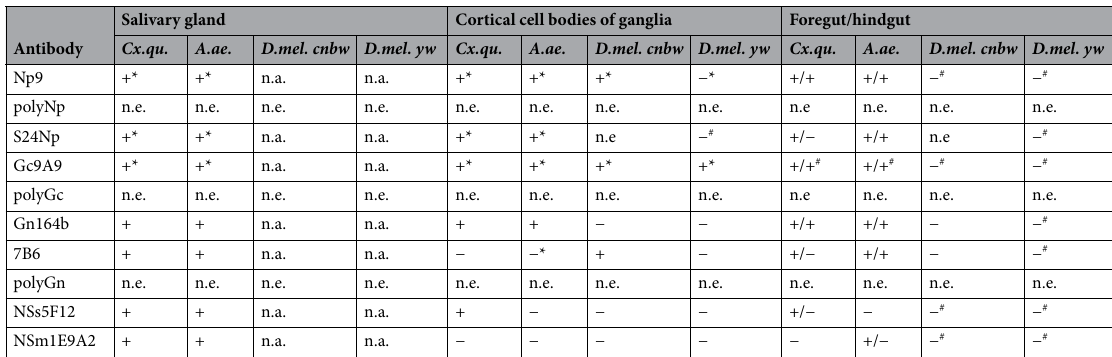
Table 3. Organs with immunopositive signals in RVFV-infected insect specimens. A.ae.: Aedes aegypti; Cx.qu.: Culex pipiens quinquefasciatus; D.mel. cnbw: Drosophila melanogaster cinnabar brown; D.mel. yw: Drosophila melanogaster yellow-white ; n.a.: not assessed; n.e.: not evaluable; +: positive reaction; −: no reaction. *false positive labeling in non-infected specimens. # unspecific background of varying degree.